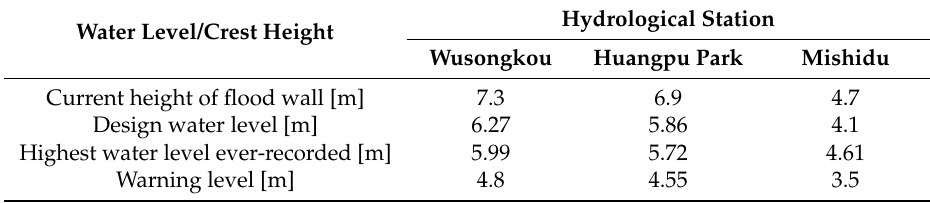
Table 2. Description of datasets for flood frequency analysis in the Huangpu River.